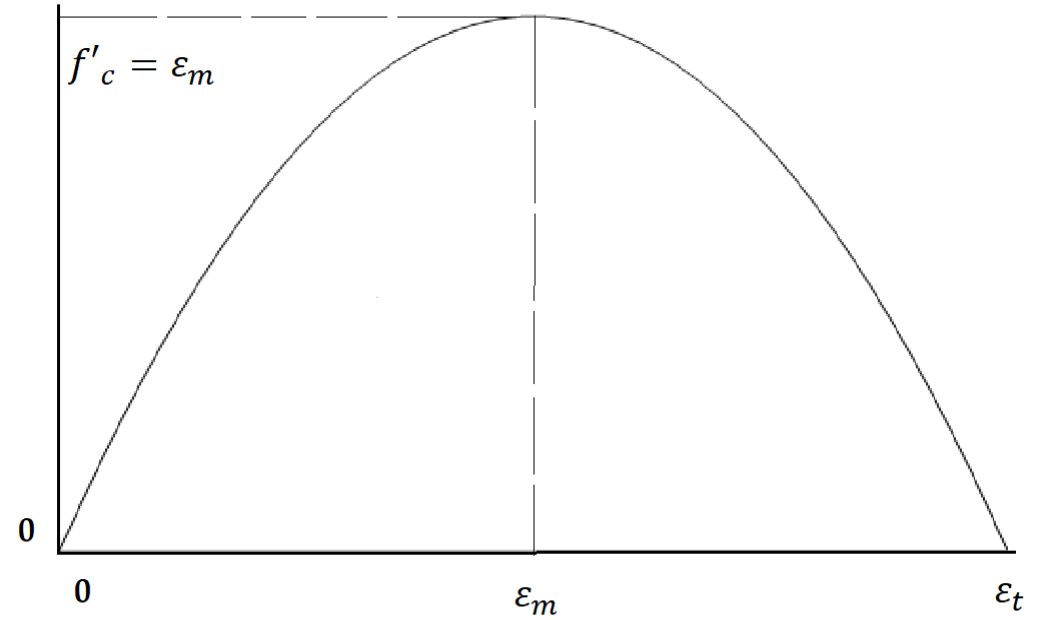
Figure 8. The conception of ideological compressive strength of the stress–strain curve is considered by the Logic